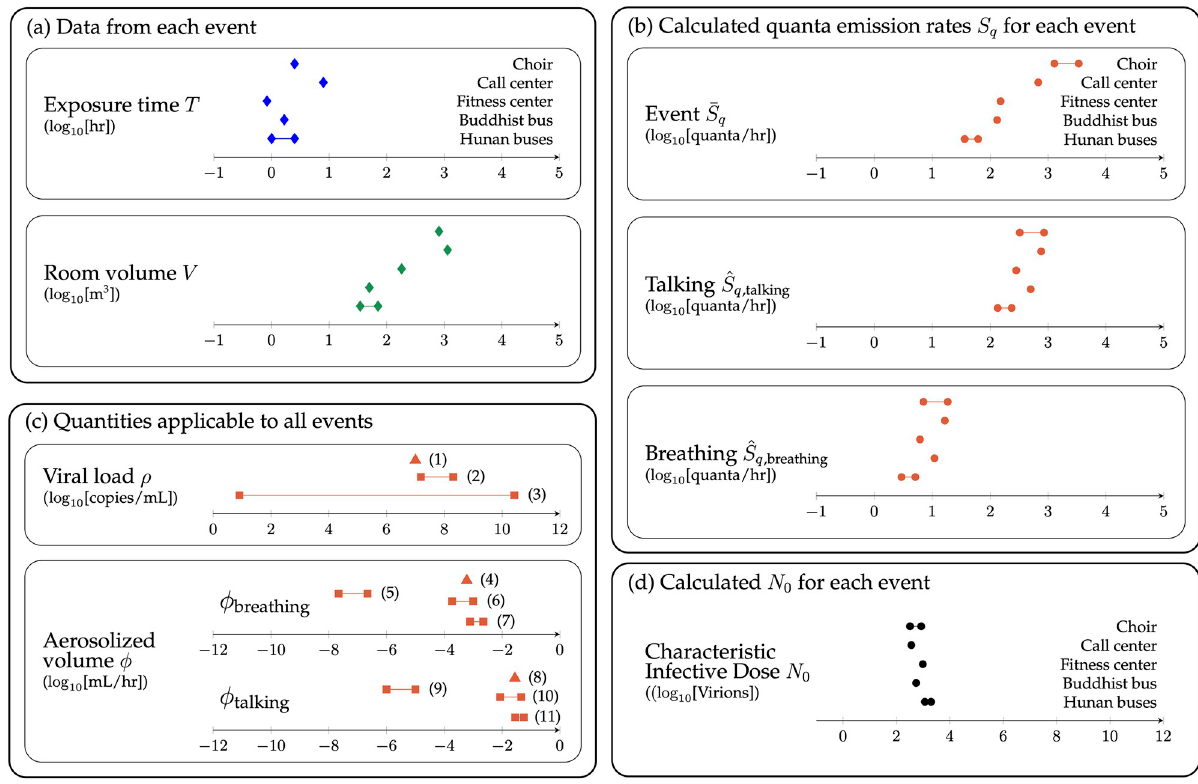
Fig 4. Key inputs and outputs. (a) Diamonds show the interaction time T and room volume V for each of the five cases, presented in the same order for both panels. Event 1 = Skagit choir, 2 = Korean call center, 3 = Korean fitness center, 4 = Buddhist bus, 5 = Hunan buses. (b) Estimated quanta emission rates for each case: S (event specific, top panel), S (middle panel), S (bottom panel). Because each event has a different mix of q q ,talking q ,breathing activities (time spent singing/talking versus breathing), the estimated event quanta emission rate S q ranges over 2 orders of magnitude. However, the estimated quanta emission rates for talking and breathing alone ( S ) range over only a factor of * 6, which is also narrower than the range in T q ,talking and V . (c) Values of viral load ρ and aerosolized volume ϕ used in this work (triangles) and in literature (circles). ρ : (1) value used in this work (10 7 copies/mL); (2) modeled peak viral load found by Goyal et al . across 25 patients [13]; (3) range observed by Kleiboeker et al . across 4,432 patients [11]; ϕ : Breathing (4) value used in this work (6.0 × 10 − 4 mL/hr); (5) range implied from Miller et al . based on Morawska et al . [6, 19]; (6) range implied from Stadnytskyi et al . (using ratio of breathing/speaking in Morawska) et al . [19, 20]; (7) range based on exhaled breath condensate (EBC) dilution measurements [21–23]; Talking (8) value used in this work (2.7 × 10 − 2 mL/hr); (9) range in Miller et al . and Morawska et al . (1–10 nL/hr) [6, 19]; (10) range in Stadnytskyi et al . [20]; (11) range in Smith et al . [24]; (d) Estimated characteristic infective dose N 0 for each of the five cases.